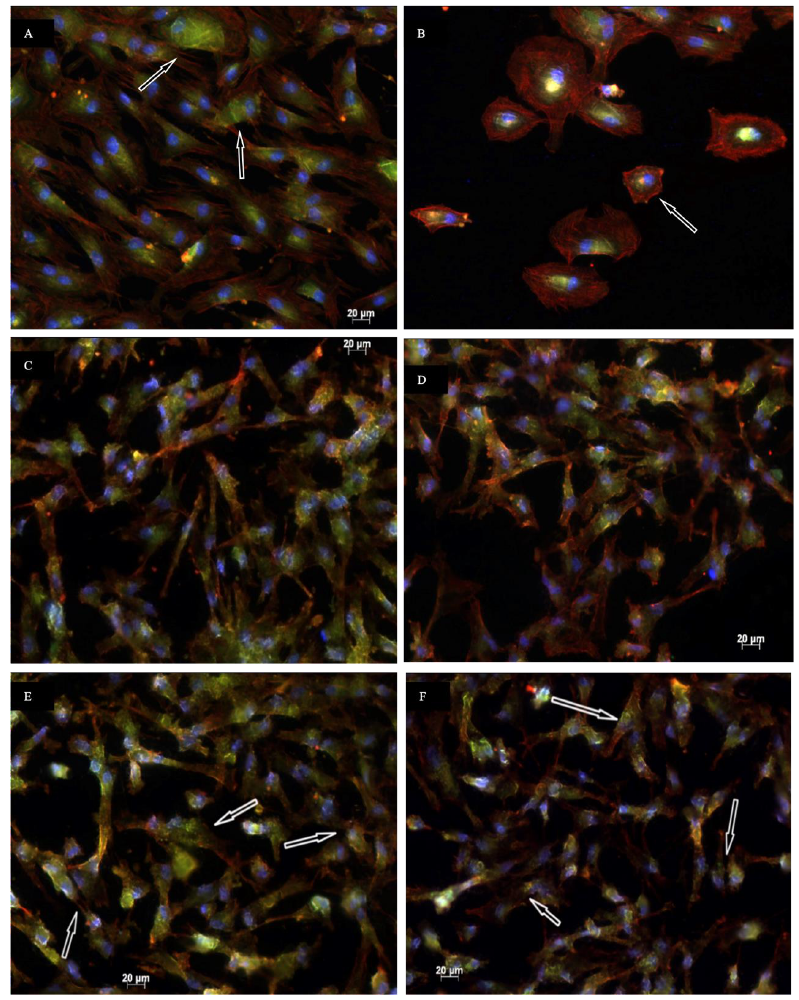
Figure 3. Representative fluorescence microscopic images of fibroblasts on microstructured titanium discs after 4, 12 and 24 h of cultivation (Vinculin, Phalloidin and DAPI stains). ( A ) Plasma-treated titanium after 4 h of culture. Cells show larger adhesion areas (green, arrows) in comparison to ( B ) control sample, gas stream without plasma ignition (red, arrow). ( C ) Treated and ( D ) un- treated titanium discs after 12 h of culture. No differences are visible for the attachment of the fibro- blasts. ( E ) Treated sample after 24 h of culture. Arrows: minimally more cells and stronger attach- ment of the individual cells and larger cell bodies in comparison to ( F ) untreated titanium discs.